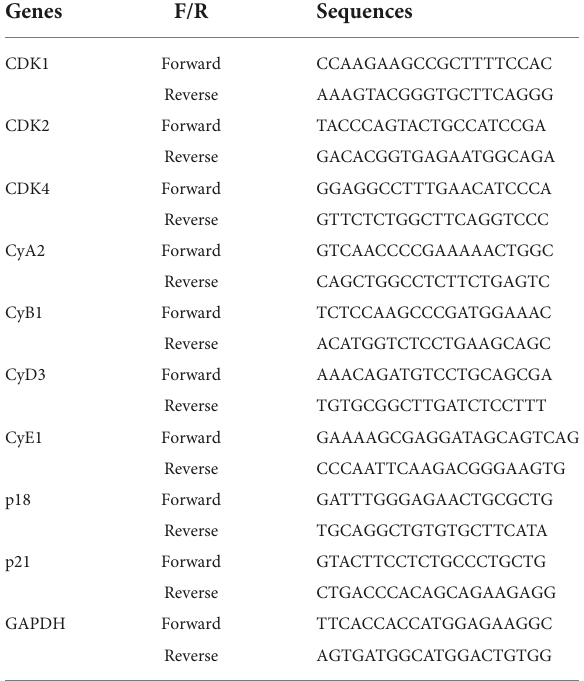
TABLE 1 The list for the sequences of